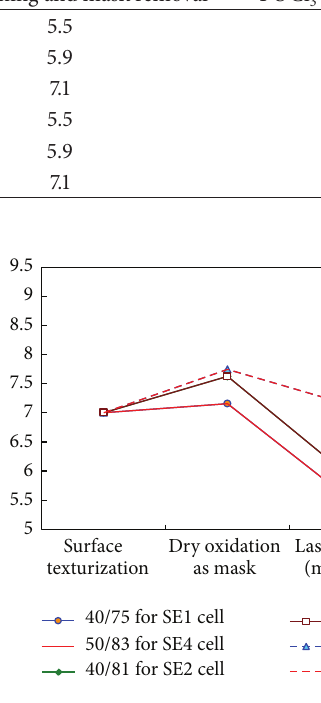
Figure 4: The variation of the average lifetime of six mc-Si wafers at different processing